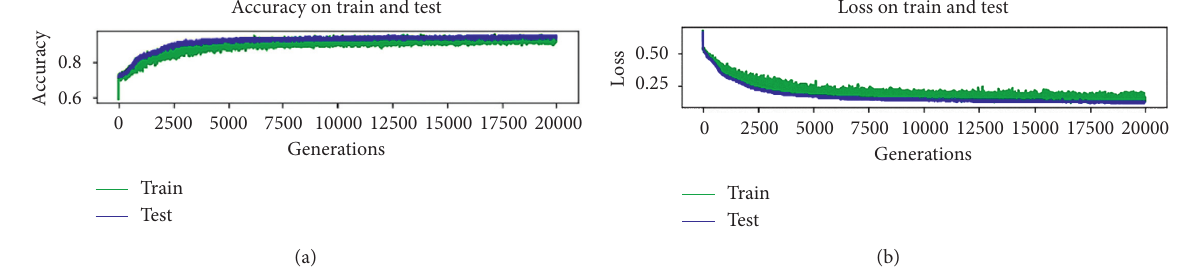
Figure 11: The accuracy (a) and the loss (b) after 20,000